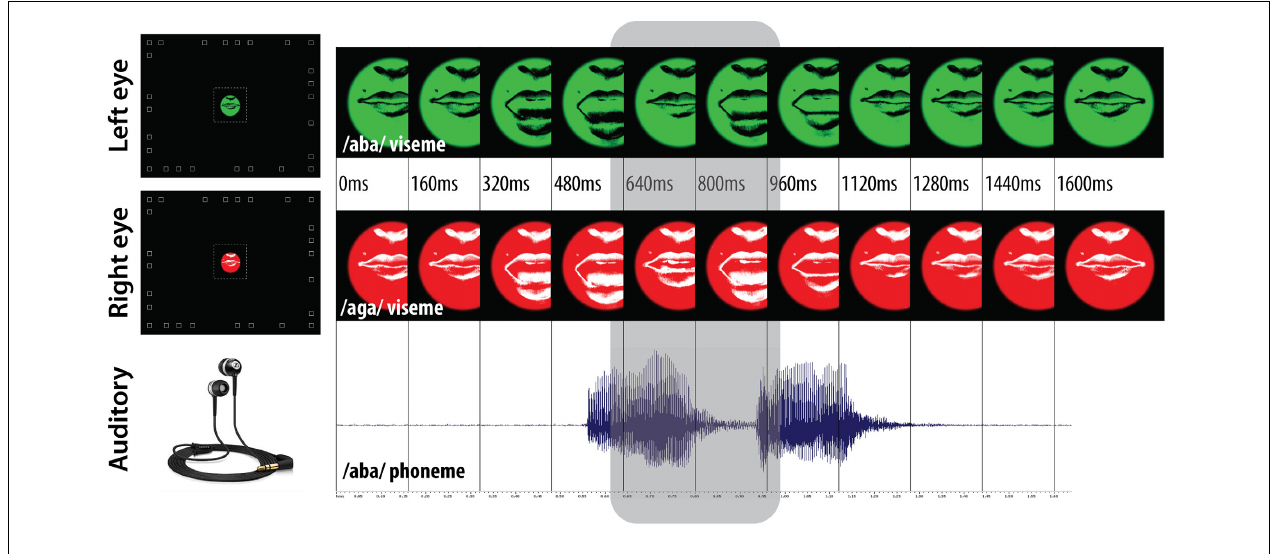
FIGURE 1 | Audiovisual stimulations. A pair of video sequences or static snapshots were displayed to the left and right eye using the NVisor SX dual-channel head mounted display, and sound was played using the Sennheiser CX300-II ear canal phones. The color filtering used (black/white lips on a green/red background) enabled rivalry of the spatially superimposed